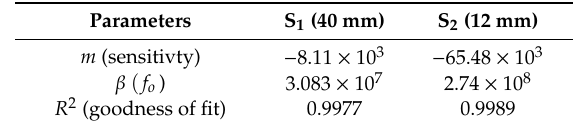
Figure 14. Reflection coe ffi cients (S11 parameter) of S 2 for a pressure range between 0 to 300 mmHg. As the response of both the sensors was linear within the targeted pressure range of 0 to 100 mmHg, a first-order polynomial was fitted over the measured response of the sensors. The coefficients of the linear fitted model are given in Table 2. The measure sensor response (dotted) and fitted curve (solid) for both sensors are shown in Figure 15. Table 2. Coe ffi cients of the polynomial equation ( f ( P ) = m × P + β ; where P is pressure) curve fitting between measured resonance frequencies and applied pressure.